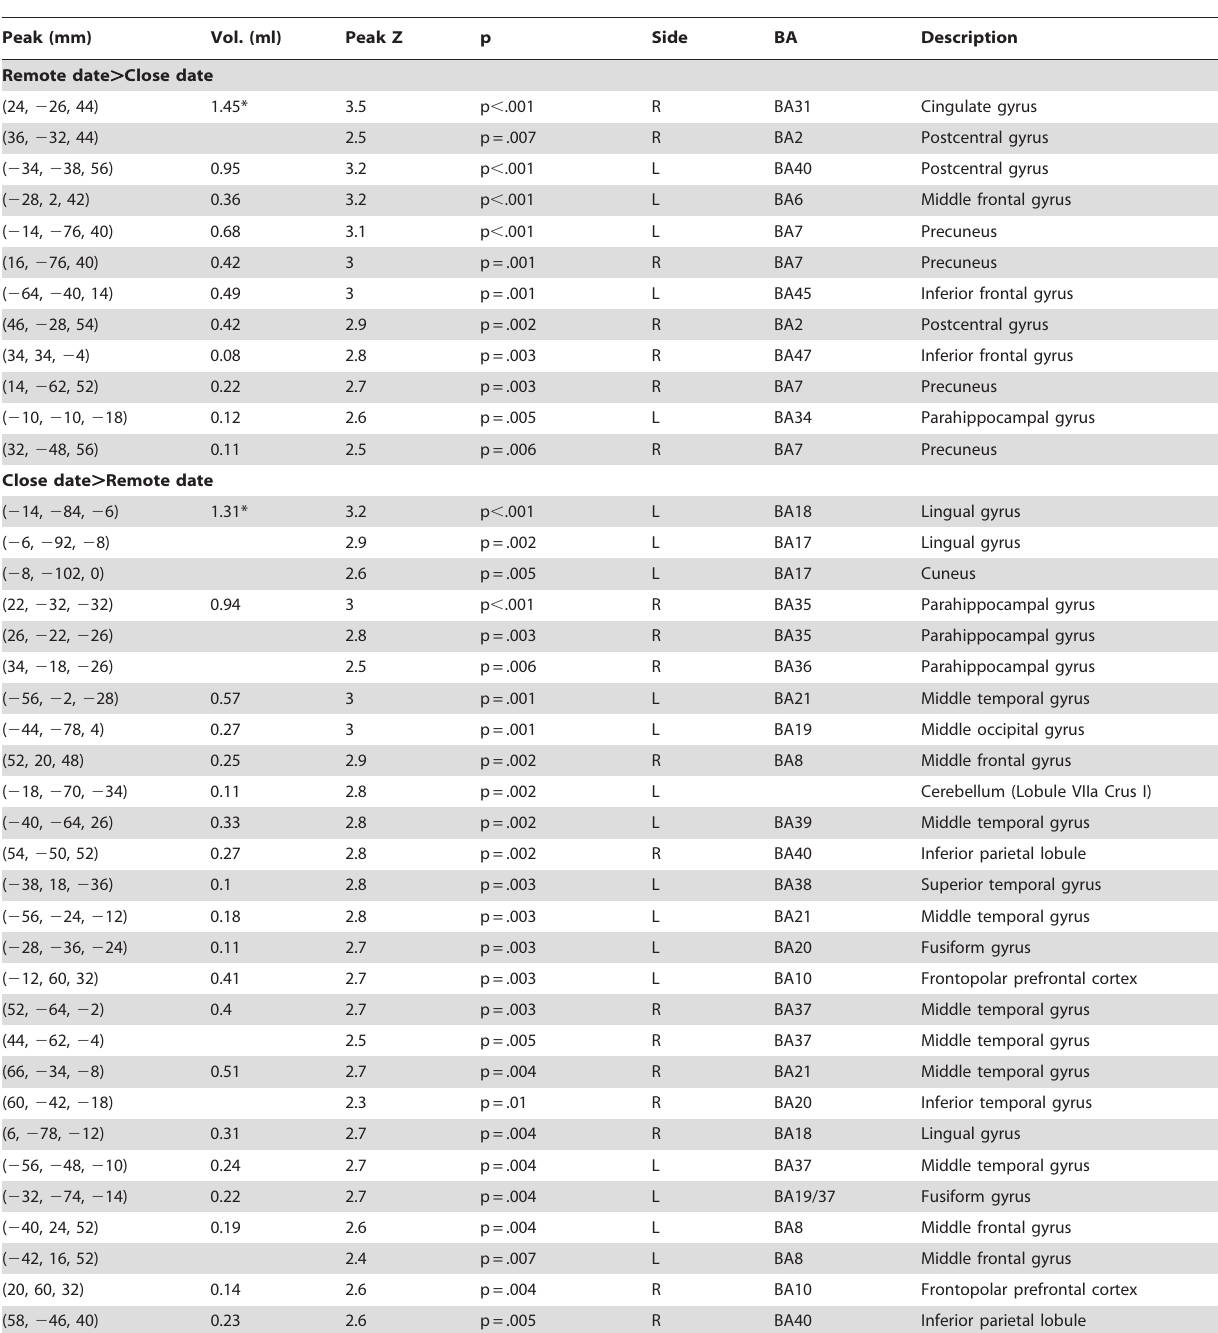
Table 3. Comparison of activity for remote and close